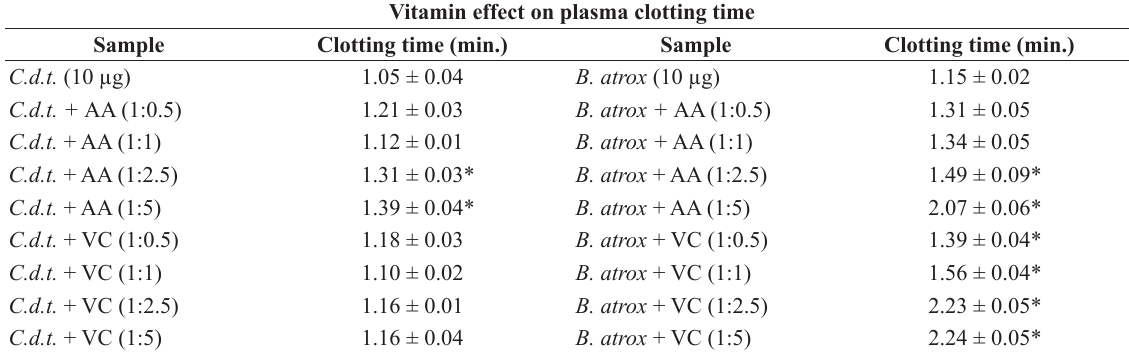
Coagulant activity induced by Crotalus durissus terrificus and Bothrops atrox venoms on human citrated plasma preincubated with vitamins in different ratios (for 5 min. at 37°C).